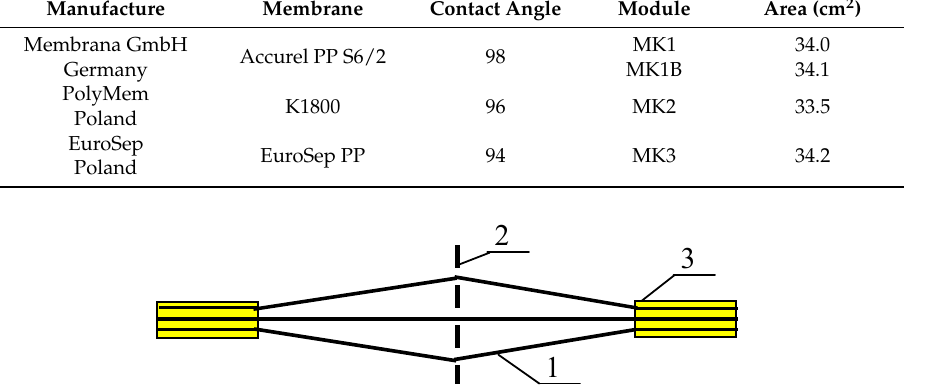
Figure 3. Design of submerged MD modules (MK1-MK3). 1—capillary membrane, 2—PP net, and 3—glass head (d inner = 7 mm).